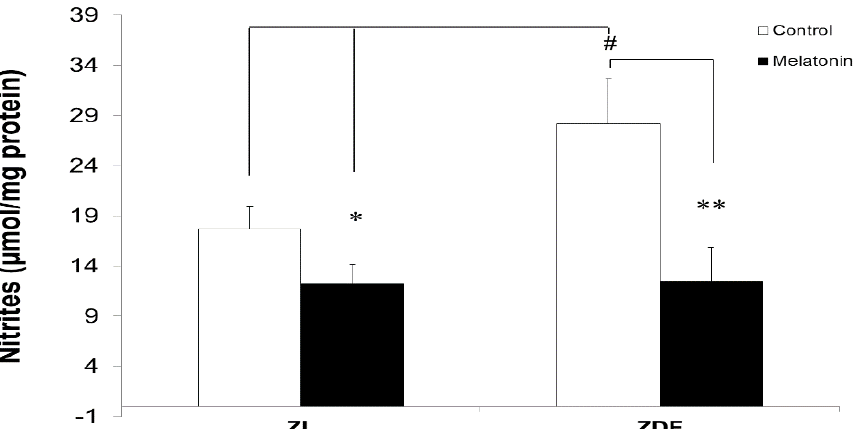
Figure 5. The effect of melatonin on nitrite levels in mitochondria isolated from BAT fat depots of control (untreated) and melatonin-treated ZDF and ZL rats. Values are shown as mean ± SD. Superscript letters express significant difference measured using two-way ANOVA followed by the Tukey post hoc test. * p < 0.05 (M-ZL compared with C-ZL rats), ** p < 0.01 (M-ZDF compared with C-ZDF rats), and # p < 0.05 (C-ZDF and M-ZDF compared with C-ZL rats).